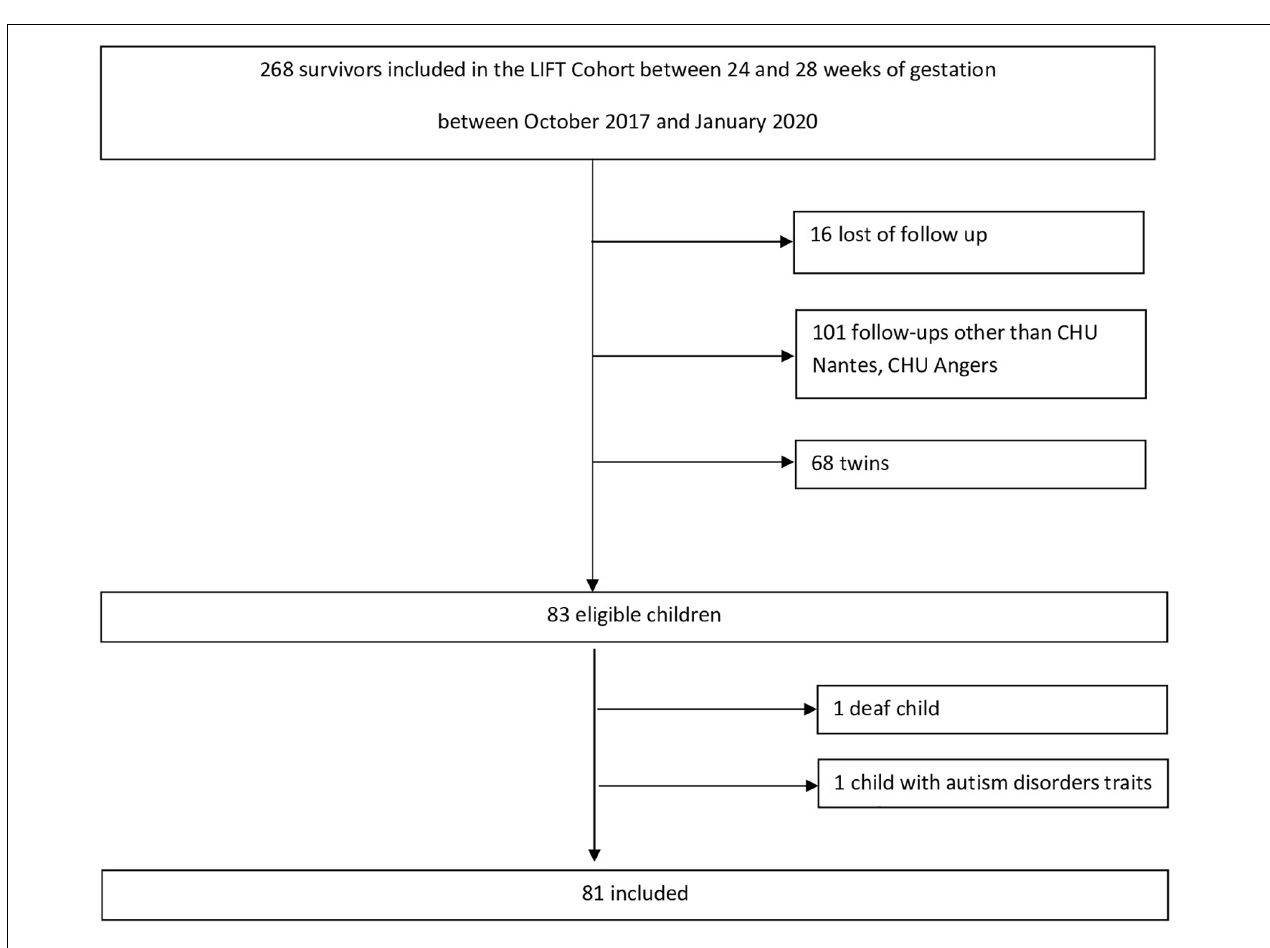
FIGURE 2 | Study flow